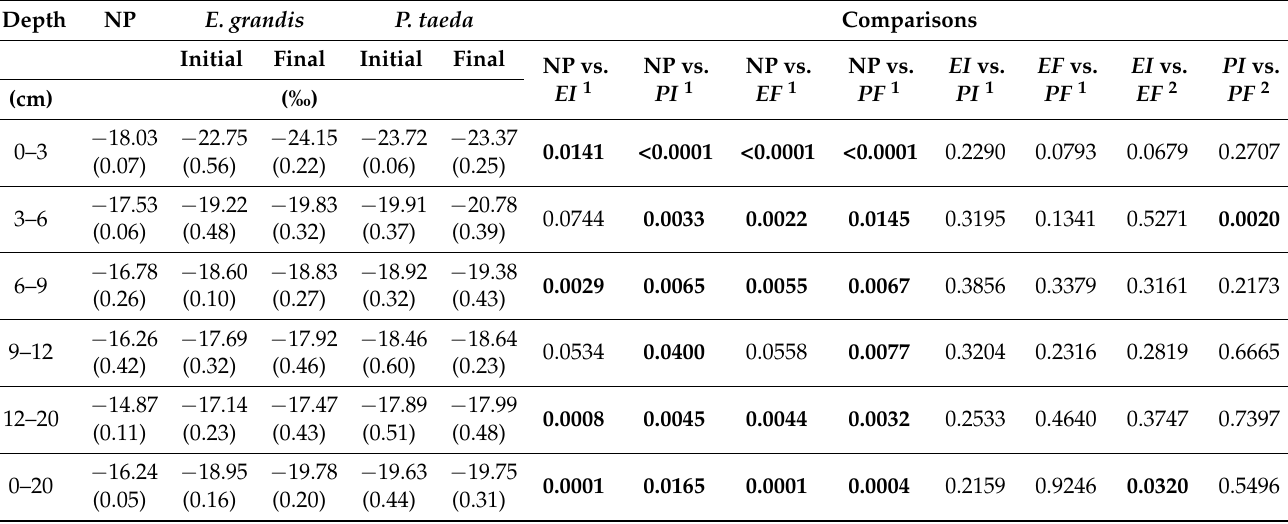
Table 7. δ 13 C values of the SOC under P. taeda , E. grandis and native pastures at the beginning and end of the